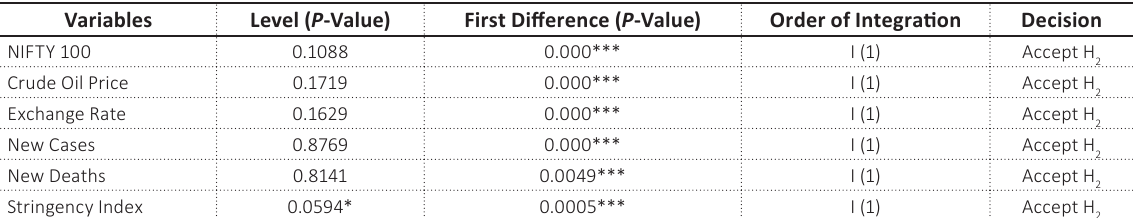
Table 2. ADF unit root